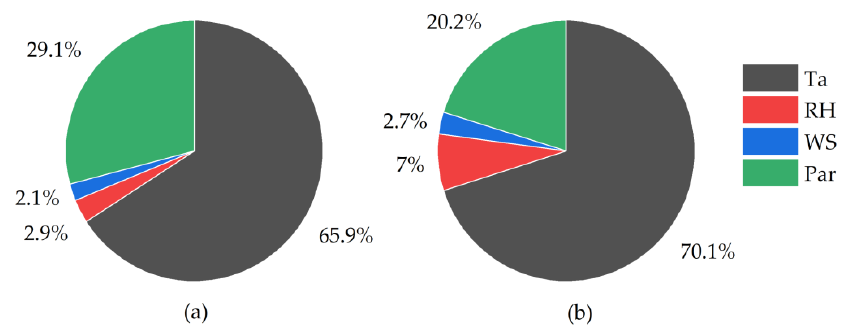
13 of 24 Figure 7. The performance of the RF model with variable numbers of decision trees and splitting nodes: ( a , c , e ): 𝑇 𝑤𝑒𝑡 ; ( b , d , f ): 𝑇 𝑑𝑟𝑦 . The feature importance of Ta, RH, WS, and Par is presented in Figure 8. The propor- tions to which Ta, RH, WS, and Par contributed to the simulation of 𝑇 𝑤𝑒𝑡 were 65.9%, 2.9%, 2.1%, and 29.1%, respectively. However, the ratios of Ta, RH, and WS used for simulating 𝑇 𝑑𝑟𝑦 slightly increased by 4%, 4%, and 1%, respectively, and that of Par decreased by 9%. Ta occupied a proportion of over 60%, indicating its dominant contribution to the model- ing process. The ANOVA results for predicting 𝑇 𝑤𝑒𝑡 and 𝑇 𝑑𝑟𝑦 are shown in Table 5. Ac- cording to the table, the significances of the F value are <0.0001, implying a distinct differ-